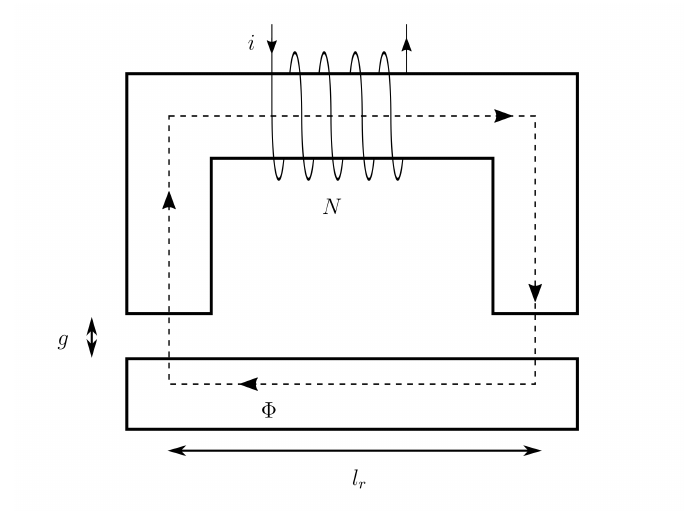
Figure 8. Magnetic circuit of the